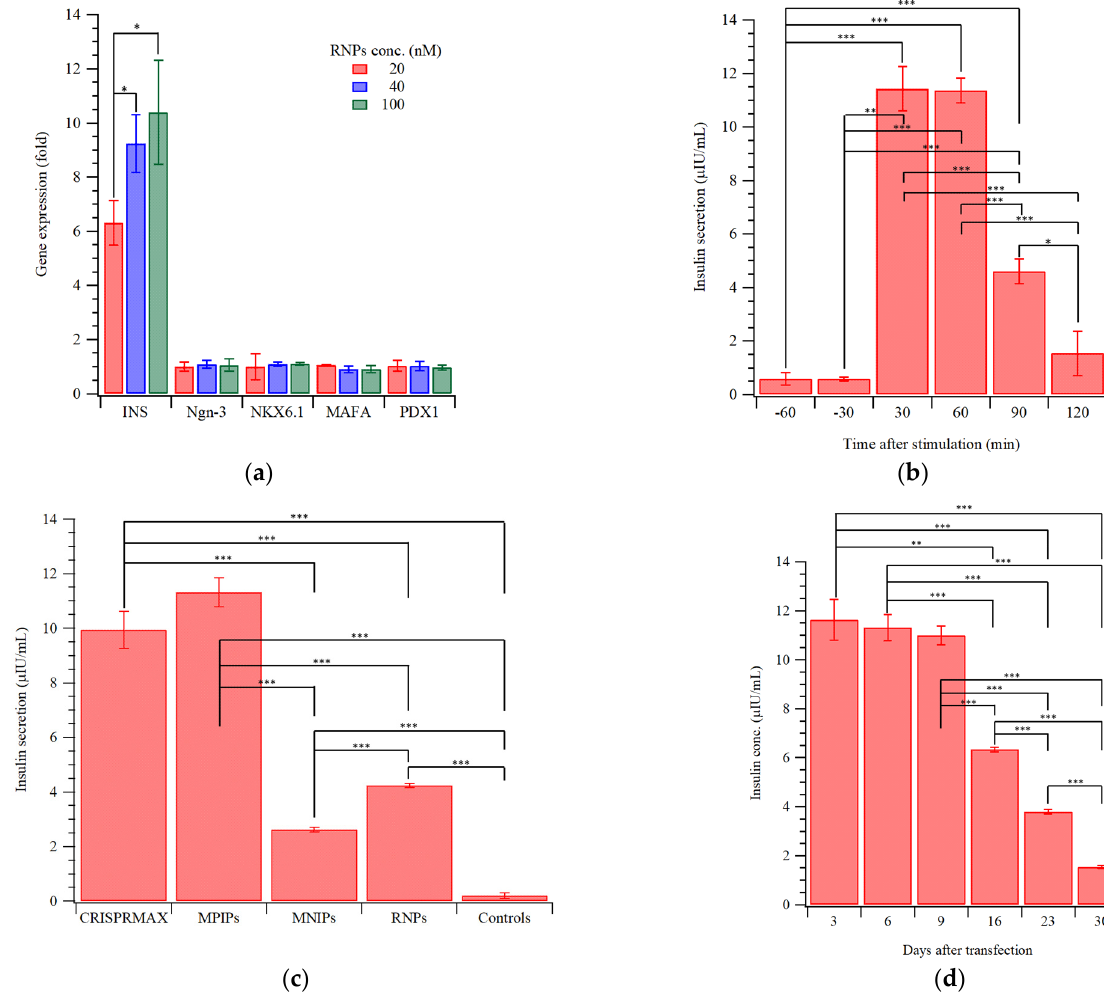
Figure 4. ( a ) Relative gene expression of key cellular differentiation genes of β -cells for activation of insulin with MPIPs/RNPs in HEK-293T cells. The administration of RNPs had no effect on the ex- pression levels of these genes. ( b ) Insulin release from transfected HEK293T cells during an hour of glucose stimulation. ( c ) Insulin secretion of controls, RNPs, with MNIP, MPIPs, or Lipofectamine™ CRISPRMAX™-treated HEK293T cells after high glucose stimulation. ( d ) Insulin secretion 30 min after glucose re-stimulation on the 3rd, 6th, 9th 16th, 23rd, and 30th day. (*: p < 0.05, **: p < 0.005, and ***: p < 0.0005) The image in ( b ) has been published elsewhere [34], where it was used only for comparison purposes. Reproduced from Ref. [34] with permission from the Royal Society of Chem- istry.